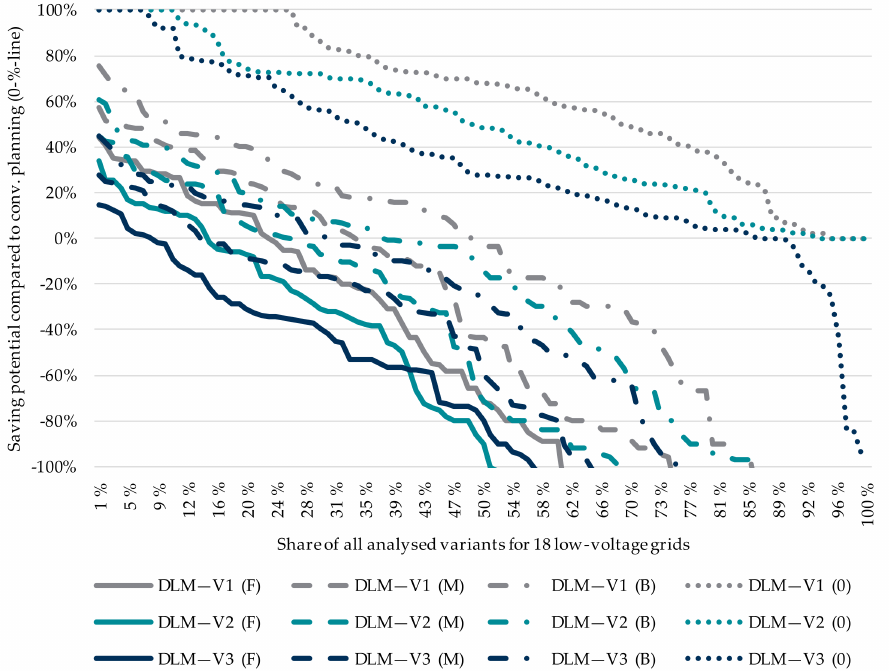
Figure 34. Savings potential of different variants of dynamic load management related to conven- tional reference variant based on the conventional reference variant for 18 low-voltage grids based on [41]; note: not shown further from −